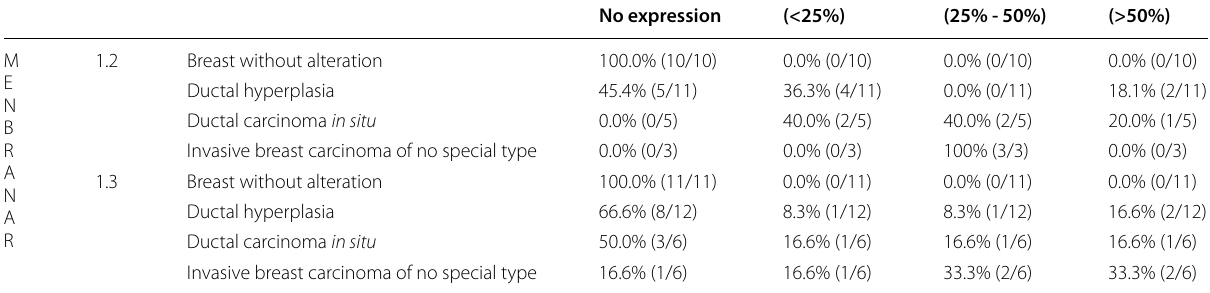
Table 4 Percentage of cases with membranar immunostaining categorized in no expression, <25%, 25% a 50%, or <50% of Ca and Ca 1.3 immunostaining in all analyzed regions. Membrane immunoexpression increase in hyperplastic and neoplastic V